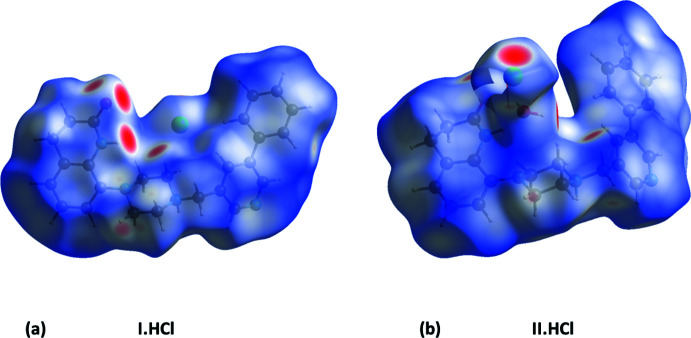
The Hirshfeld surfaces of compounds I·HCl and II·HCl, mapped over d
norm in the colour ranges of −0.5847 to 1.5642 au. and −0.5555 to 1.5111 au., respectively.